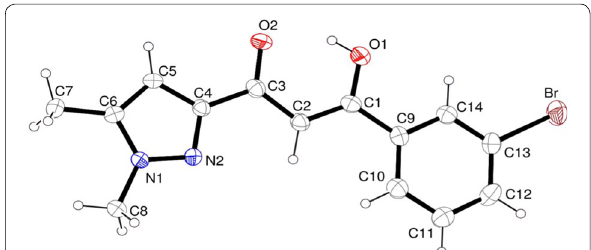
Fig. 1 Ortep molecular representation of C 14 H 13 Br N 2 O 2 (30% probability